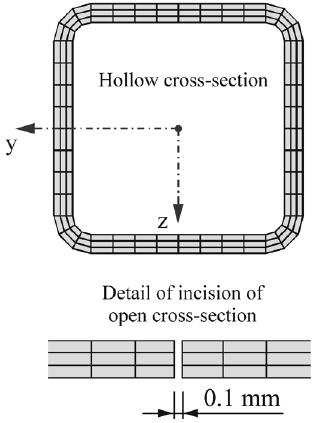
Fig. 2. Cross mesh of finite element BEAM188